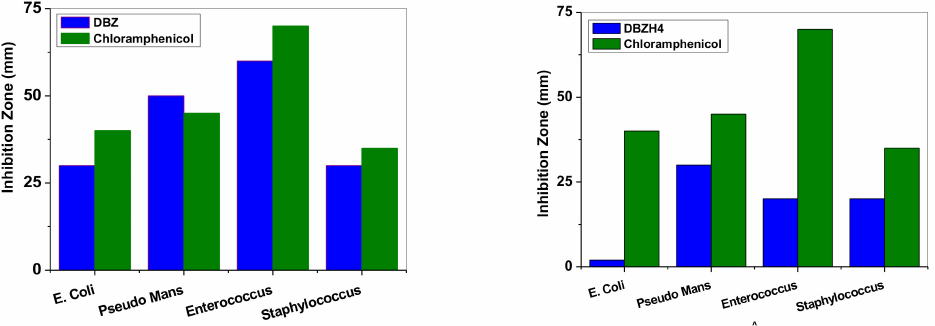
Figure 7. Energy transfer efficiency of BSA with increasing concentration of the zinc complexes. Table 3. The efficiency of energy transfer, overlap integral, and the distance parameters for DBZ – BSA and DBZH 4 – BSA .